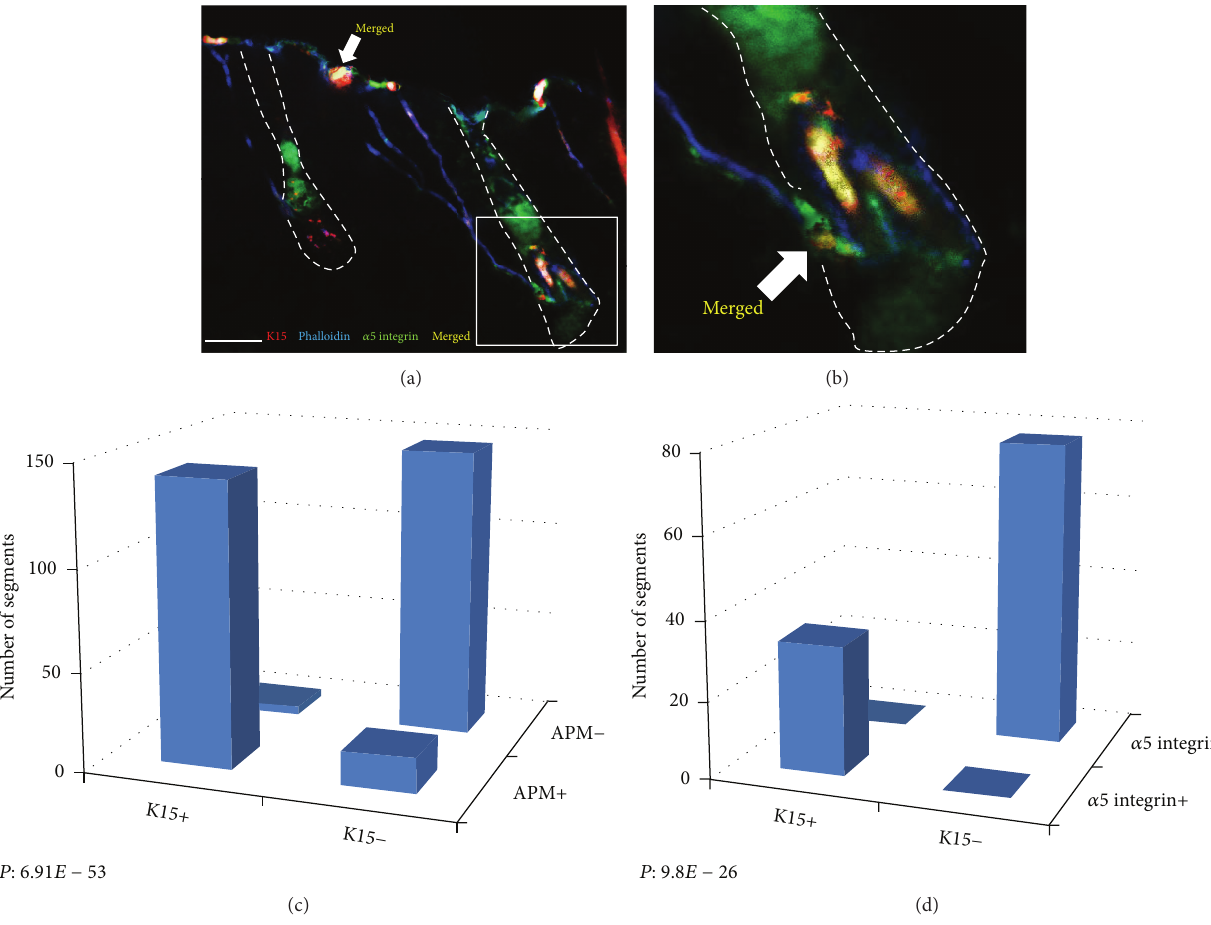
Figure 3: (a) Triple immunofluorescence staining for K15 (red), 𝛼 5 integrin (green), and phalloidin (blue) showing K15 and phalloidin expressing cells in the basal epidermis at the distal tip of the arrector pili muscle (blue). Marked overlap (yellow) of K15 (red) and 𝛼 5 integrin (green) expressing cells in the basal epidermis. (b) Magnified view of the proximal attachment of the APM to the follicle. Expression of K15 and 𝛼 5 integrin at the bulge is evident. (c-d) Strong correlation between K15 and phalloidin and also K15 and 𝛼 5 integrin expressing cells in the epidermis. Scale bar: 100 𝜇 m.